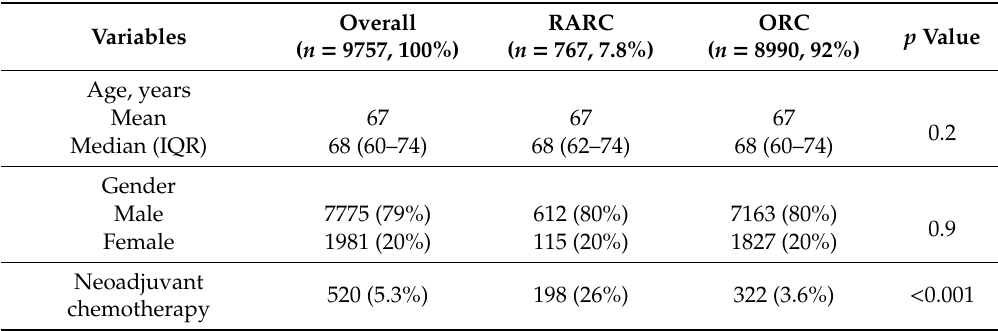
Table 1. Clinicopathologic demographics of 9757 patients with bladder cancer treated with radical cystectomy according type of